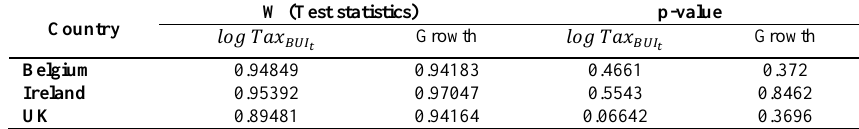
Table 1. Resulting statistic values and p-value of the Shapiro-Wilk normality test